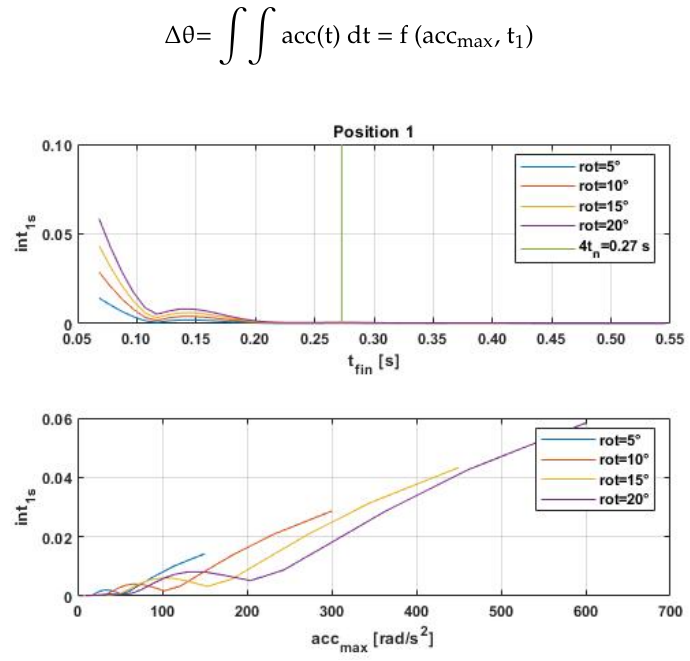
Figure 8. Index int 1s as function of t fin , acc max and rotation amplitude (rot) actuating bushing 1 in calibration position.